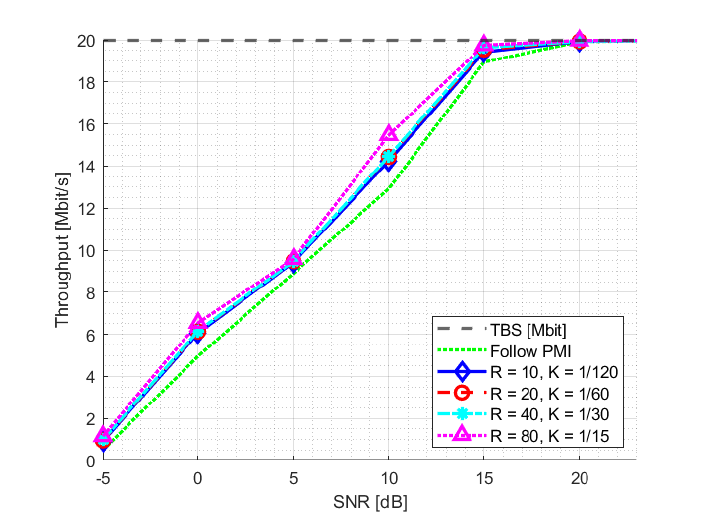
Figure 9. Throughput statistics for NR-CsiNet model trained at SNR = 20 dB [32].